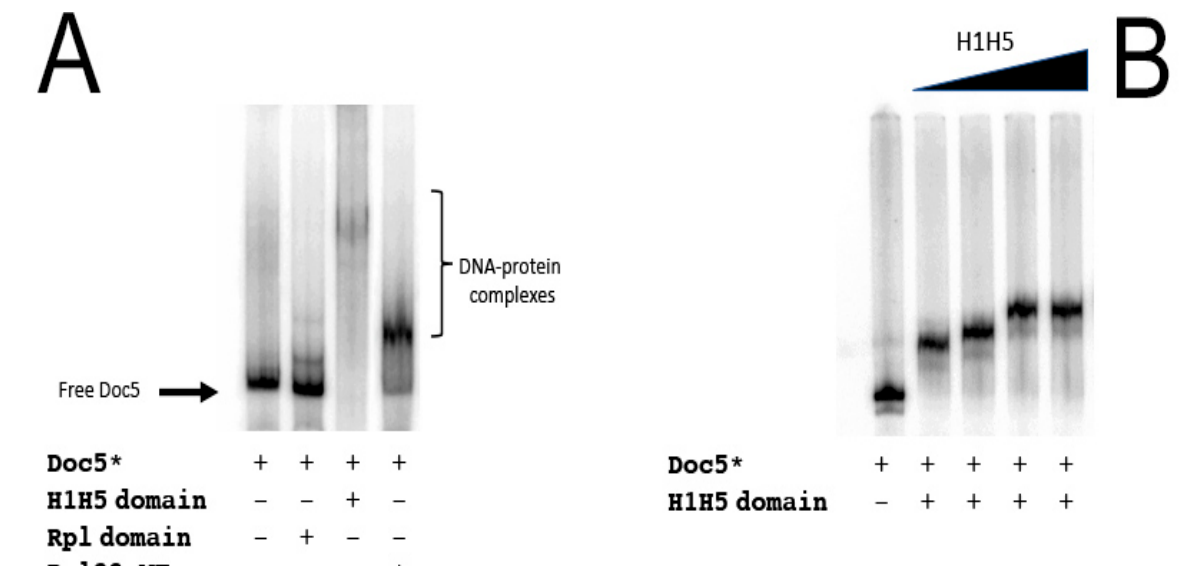
Figure 4. Dissection of the DNA-binding domain of Rpl22 in vitro. Labeled fragments are indicated with an asterisk (*). ( A ) EMSA analysis of the ribosomal and the histone-like domains of Rpl22. ( B ) EMSA analysis of the histone-like domain. A total of 3 μ g of the Rpl22 (WT) and 1.5 μ g of the H1-H5 and ribosomal domains were used to maintain the unaltered DNA:protein molar ratio. A schematic representation of the two main domains of Rpl22 protein is depicted at the top of the figure. Asterisk indicates that the fragment is labelled.